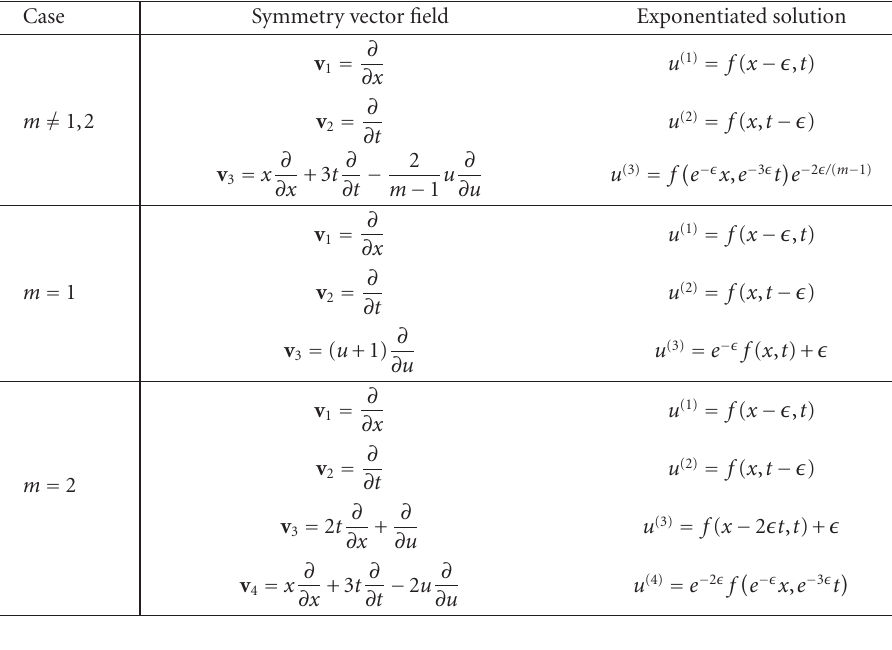
Table 2.1. Symmetry algebra spanning vector fields and exponentiated solutions for (2.1). The case m = 2 corresponds to the usual KdV